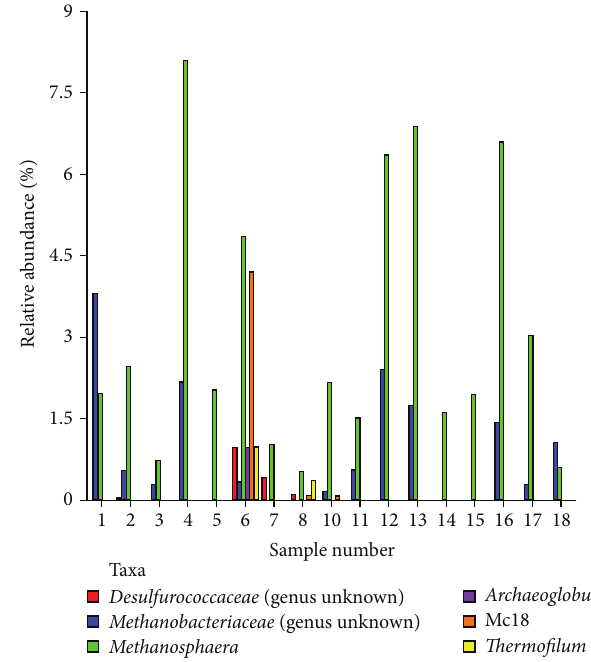
Figure 5: The 6 most abundant archaea genera ( Methanobrevibac- ter , Desulfurococcaceae , Methanosphaera , Archaeoglobus , Mc18, and Thermofilum ) in the hindgut of various levels of pine bark (PB) diets from a common cohort of 17 meat goats. Clustering in the 𝑌 direction is indicative of abundance, not phylogenetic similarity. 0% PB (control) = sample (or tag) number 1, 2, 3, 4, 5, and 6; 15% PB = tag number 7, 8, 10, 11, and 12; 30% PB = tag number 13, 14, 15, 16, 17, and